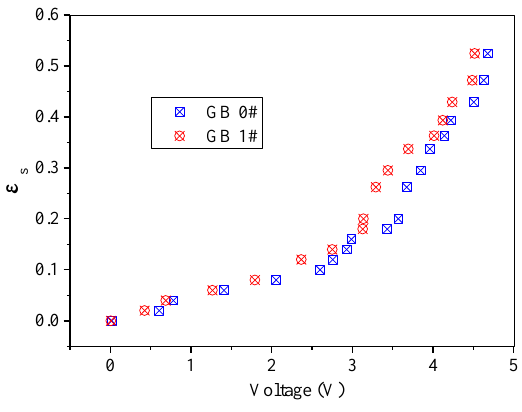
Figure 11. Effect of particle color on the calibration results.